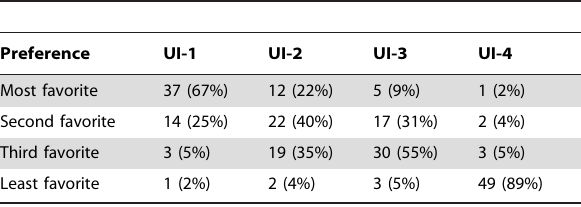
Table 4. Probability of user interface being second favorite(the last four rows) given the most-favorite user interface(the first row).